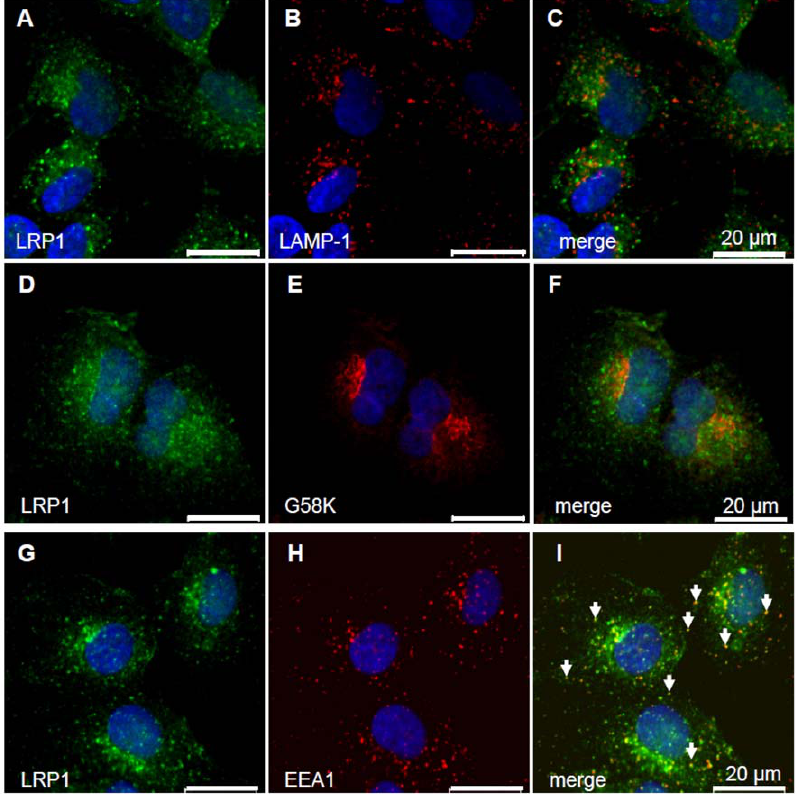
Figure 1. Endogenous LRP1 colocalizes with early endosomes markers. LRP1 was co-stained with LAMP-1 (A–C), the Golgi marker G58K (D– F) and EEA1 (G–I) in human hepatoma cells (HuH7) using respective antibodies. Confocal microscopy demonstrated a strong colocalization of LRP1 with the early endosome marker EEA1 in punctate peripheral and perinuclear endosomal structures (see arrows in the merged image, panel I). Nuclei appear in blue. Bar is 20 m m.